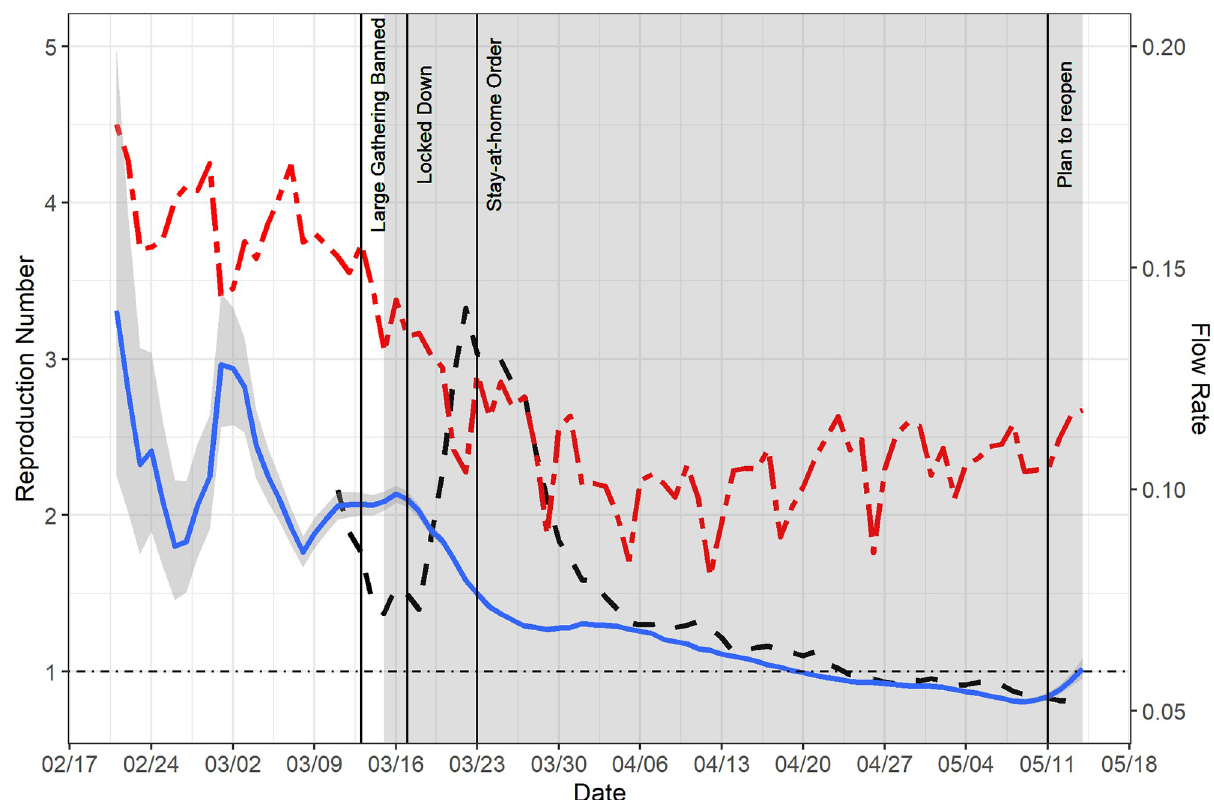
Fig 6. Estimated instantaneous reproduction number of COVID-19 and daily flow rates in Massachusetts. The estimates were calculated based on EpiEstim and a posterior sample of epidemic curve estimates (the blue curve). We identify the dates for four key policies: large gathering banned (March 13, 2020), lock-down (March 17, 2020), stay-at-home order (March 23, 2020) and the plan of reopening (May 11, 2020). By comparison, the reproduction number estimates based on the reported curve are described by the dashed black curve. The average daily flow rates over all the counties in Massachusetts was overlaid on the same plot to illustrate the mobility pattern (the red curve).